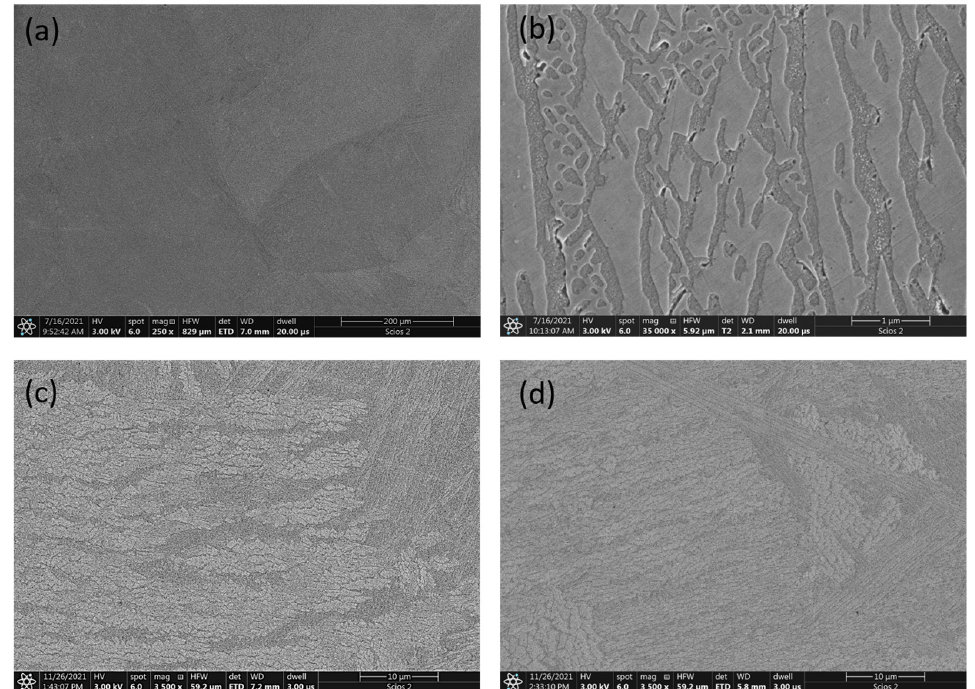
Figure 7. SEM micrographs of Al 0 . 7 CoCrFeNi alloy: ( a , b ) as ‐ cast, ( c ) annealed at 500 °C, and ( d ) annealed at 900 °C.